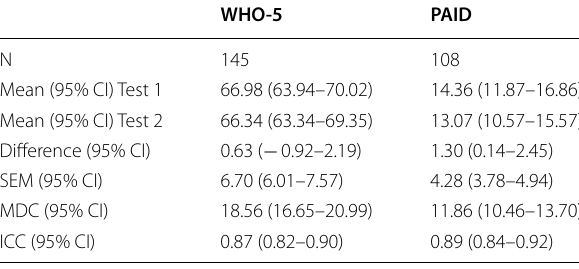
Table 4 Test–retest reliability and measurement error of the WHO-Five Well-being Index (WHO-5) and the Problem Areas in Diabetes (PAID) scale between Test 1 and Test 2